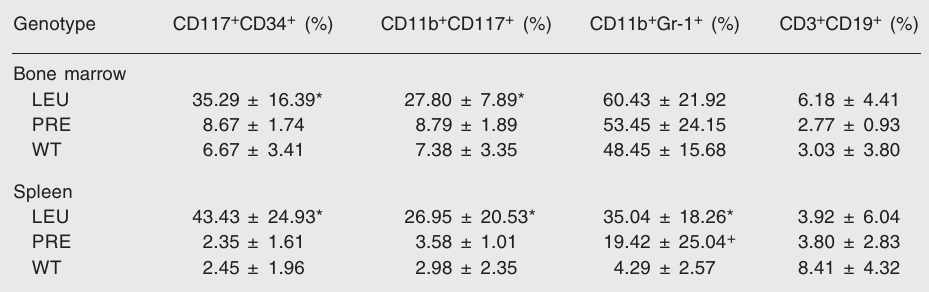
Data are reported as mean ± SD. LEU = leukemic mice; PRE = pre-leukemic mice; WT = wild-type mice. *P < 0.05 for LEU vs PRE and LEU vs WT comparison. + P < 0.05 for PRE vs LEU and PRE vs WT comparison. One-way ANOVA followed by Bonferroni’s multiple comparison